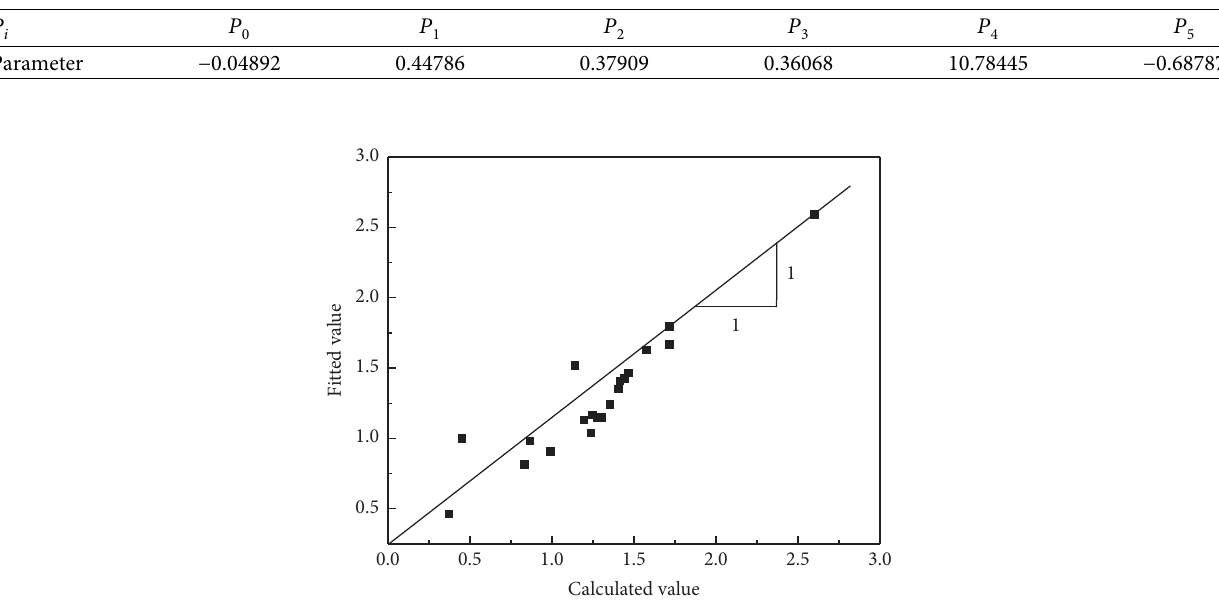
Figure 26: Fitting effect